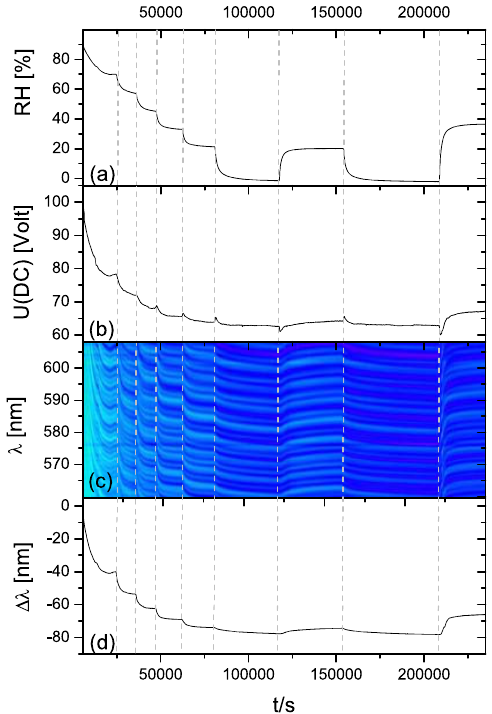
Figure 2. Typical experimental run on a shikimic acid particle with dry radius of 8.385µm at T = 293 . 5K. (a) Relative humidity mea- sured close to the droplet. (b) DC voltage compensating gravita- tional force. (c) False color map of intensity of Mie resonance spec- tra measured with the LED (dark color low intensity, bright color high intensity). (d) Shift in wavelength (cid:49)λ = λ(t) − λ 0 of a res- onance initially ( t = 0) being observed at λ 0 = 578 . 99nm. When this resonance leaves the spectral window, we continue by follow- ing another resonance as described by Zardini et al. (2006). Vertical dashed lines indicate humidity change.